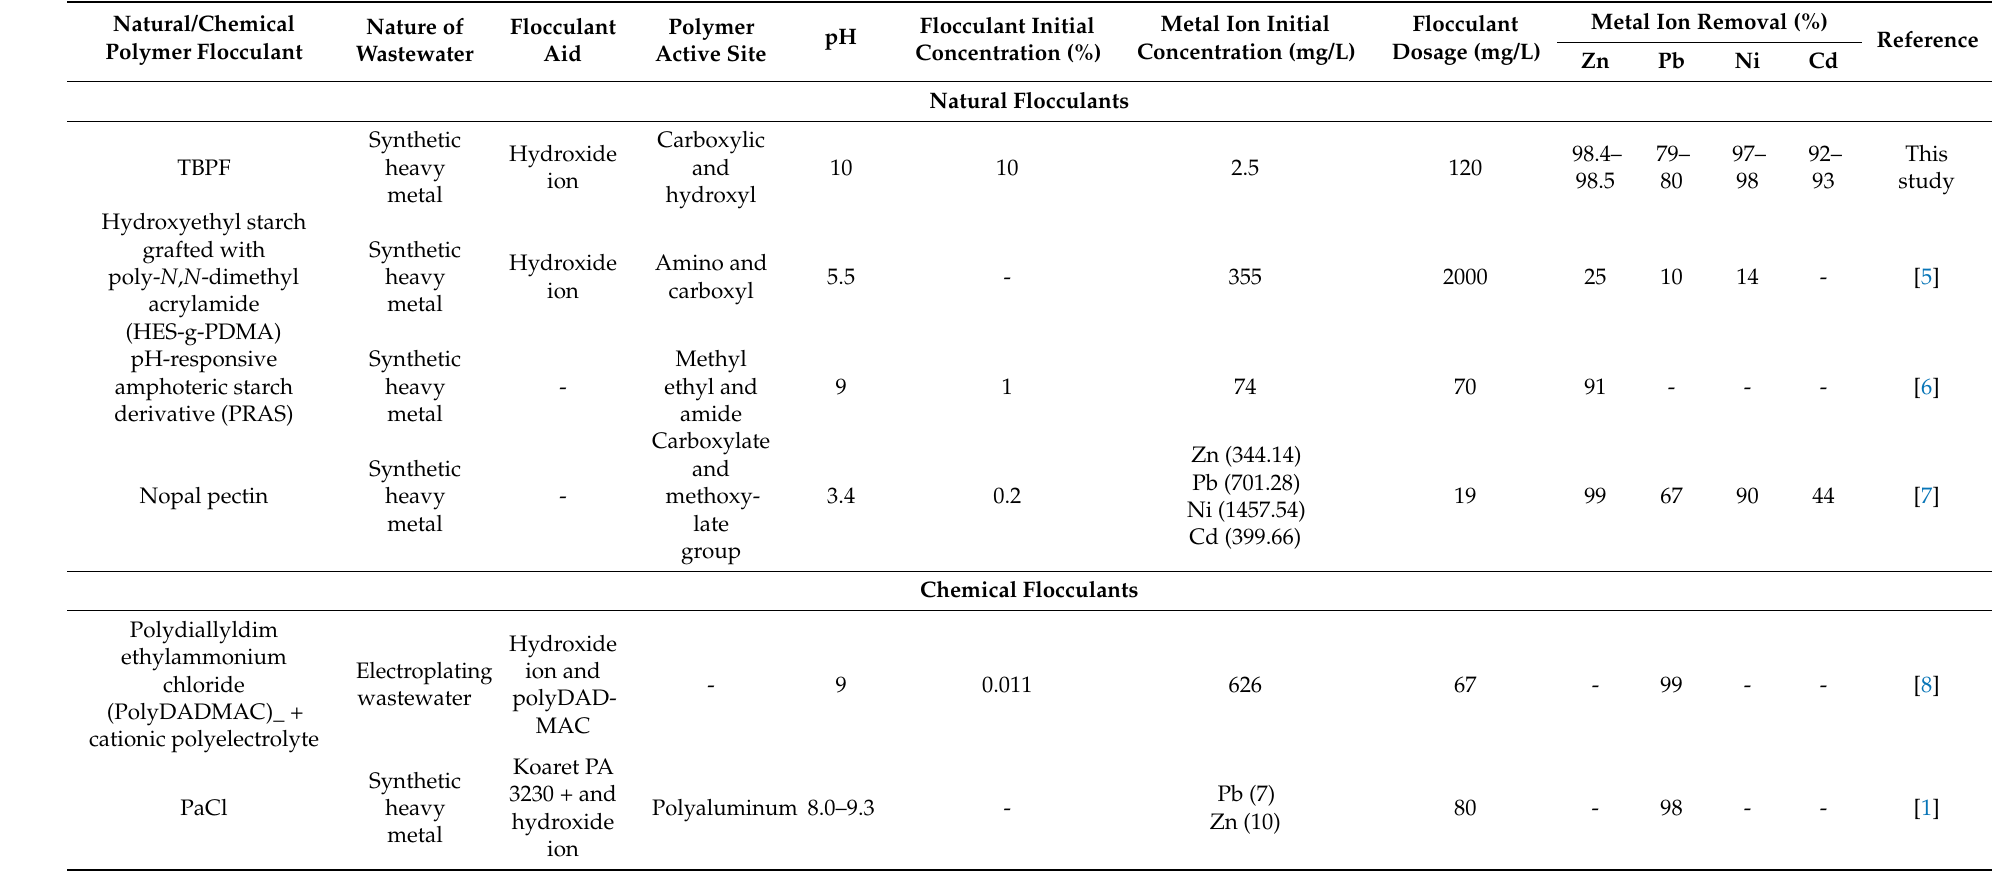
Table 2. Comparison of metal ion removal by TBPF with other